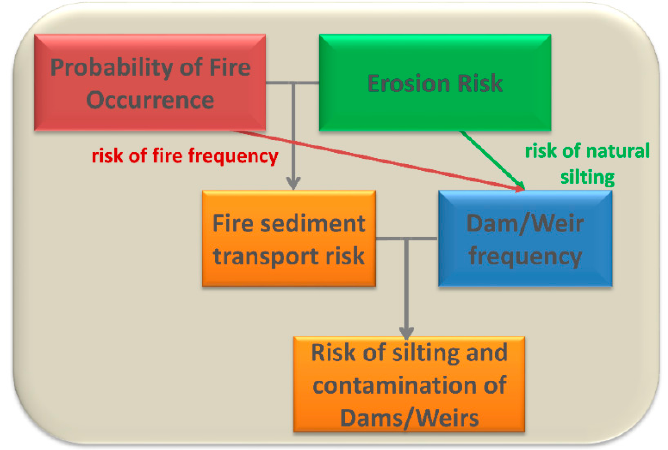
Figure 3. Workflow of the risk of silting of the Dam or weirs reservoirs.